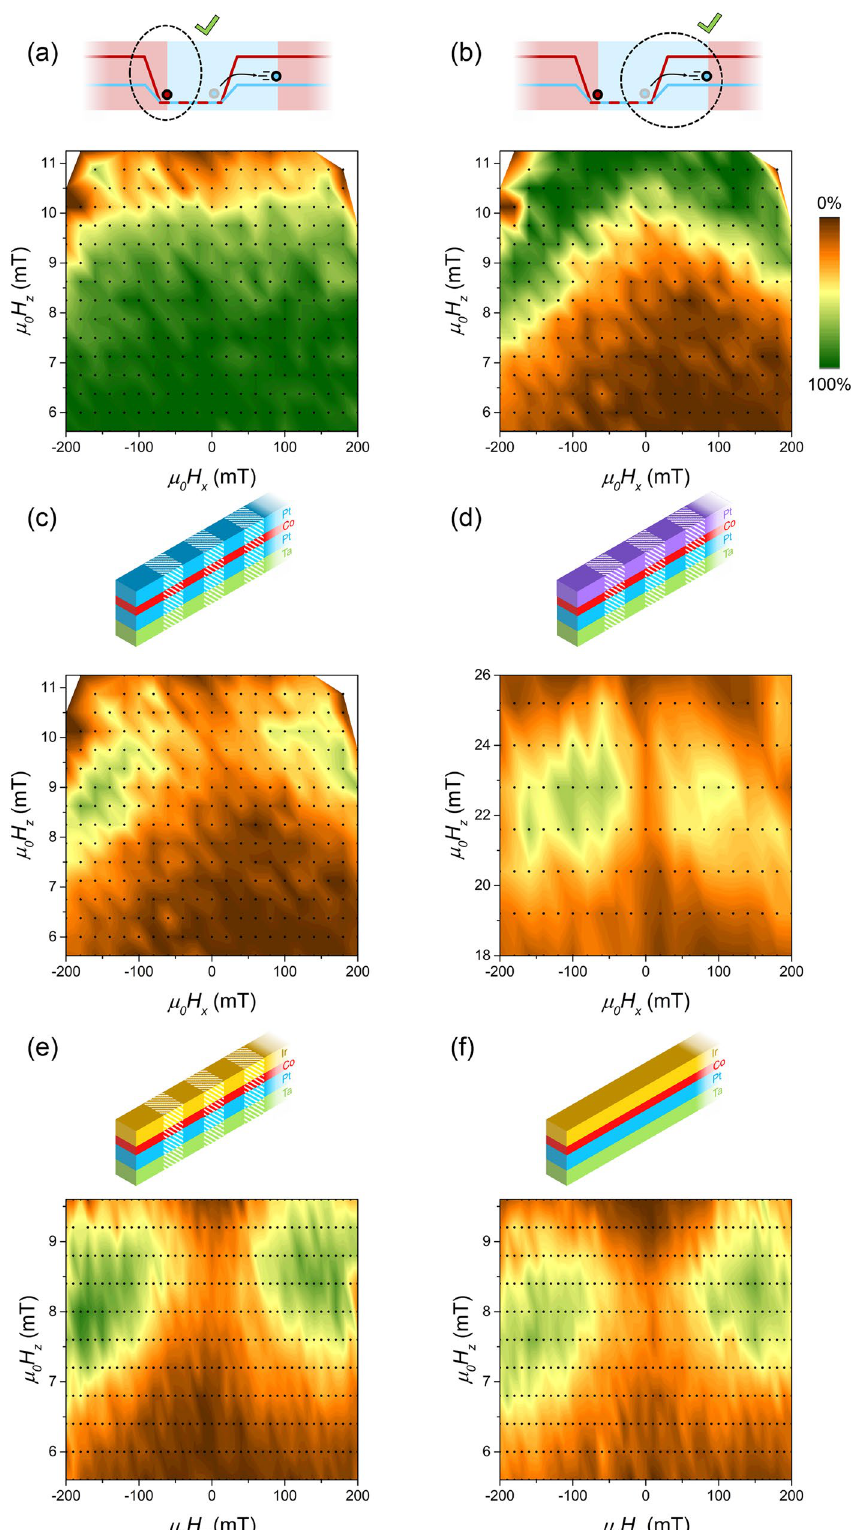
Figure 3. Success rate (indicated by colour scale) as a function of H x and H z . ( a ) Chance on a successful pinning step. ( b ) Chance on a successful depinning step. ( c ) Chance that a complete procedure (both pinning and moving) is successful for the proof-of-principle sample. ( d ) Chance that a complete procedure is successful for a sample with the top Pt layer grown at a higher pressure. ( e ) Chance that a complete procedure is successful for an irradiated Pt/Co/Ir sample. ( f ) Chance that a complete procedure is successful for an unirradiated Pt/Co/Ir